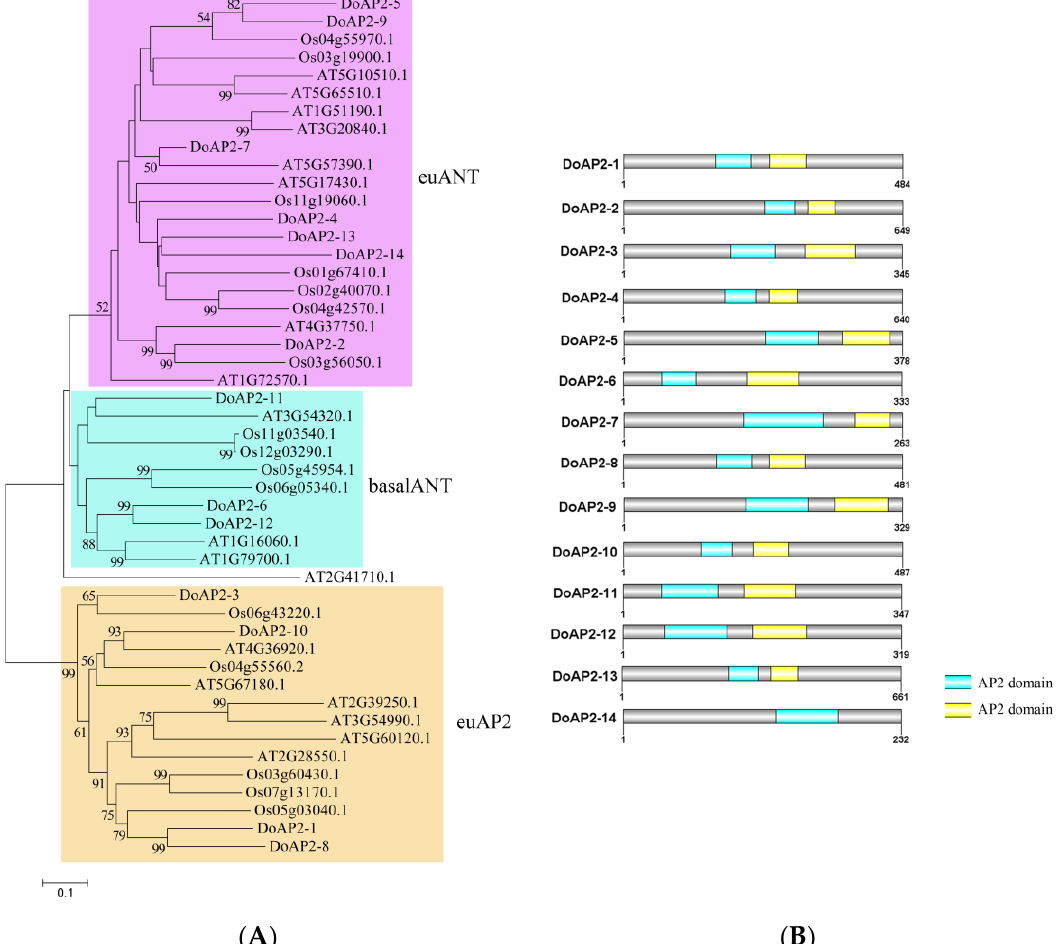
Figure 1. Phylogenetic analysis and conserved domain of the AP2 proteins from D . officinale , O. sativa and A . thaliana . ( A ) Phylogenetic tree of DoAP2 proteins. A total of 14 AP2 proteins from D . officinale , 16 from O. sativa and 18 from A . thaliana were aligned using ClustalX to generate a FASTA alignment file. The phylogenetic tree was constructed using the MEGA 7.0 program and the neighbor-joining (NJ) method with 1000 bootstrap replications based on the alignment file; ( B ) Conserved domain of DoAP2 proteins. The location and size of AP2 domains are shown by different colors.